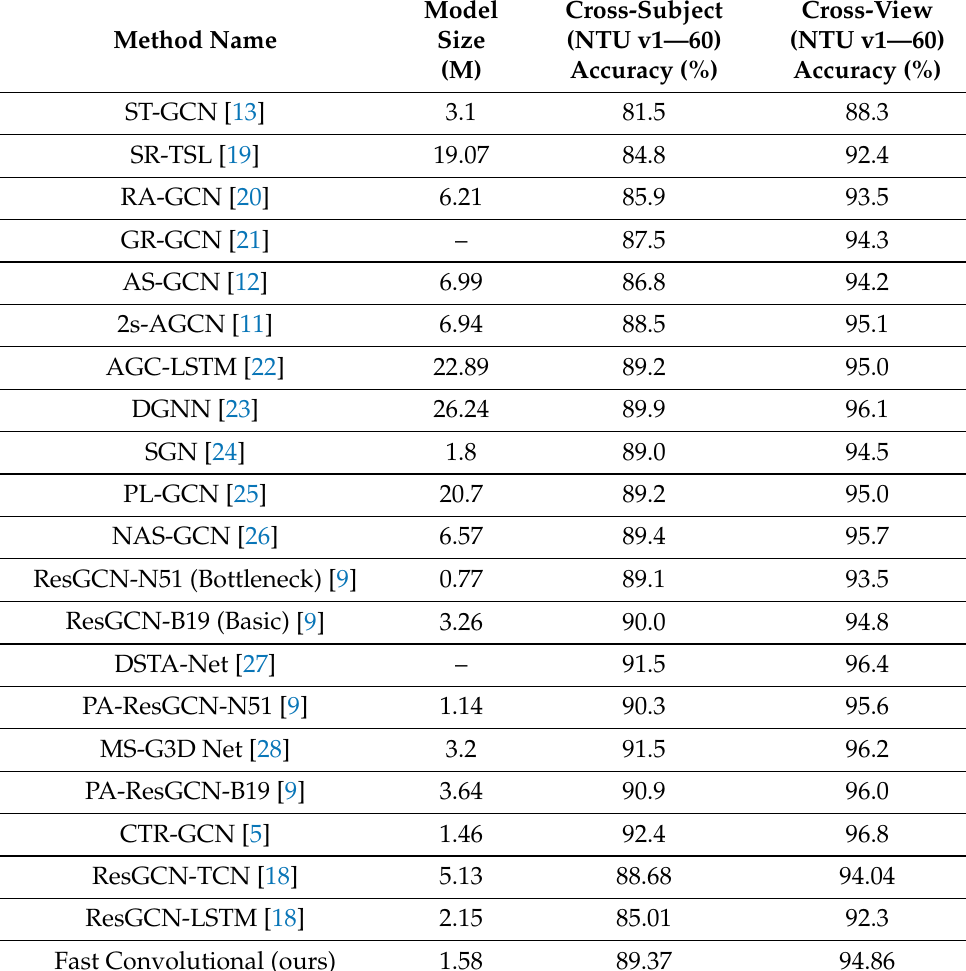
Table 4. Comparative results from the perspective of accuracy for the proposed test protocols in the first version of the NTU RGB+D dataset